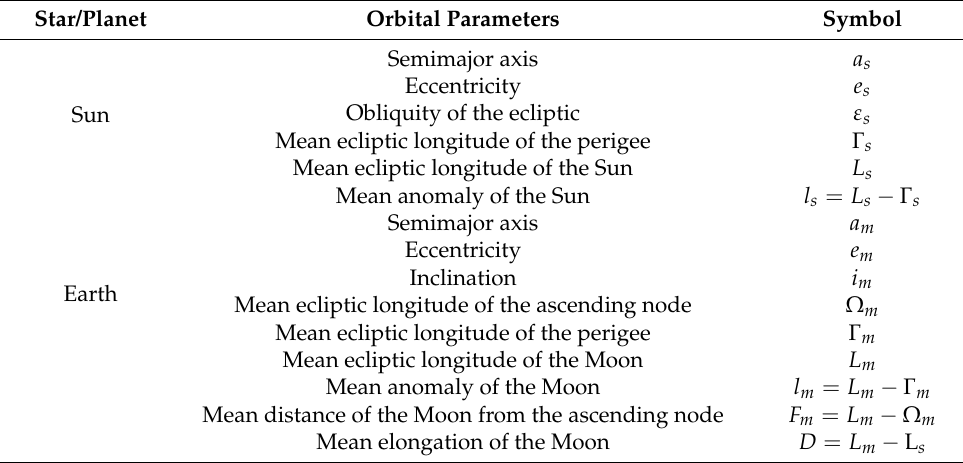
Table 1. Orbital parameters of the Sun and Moon.